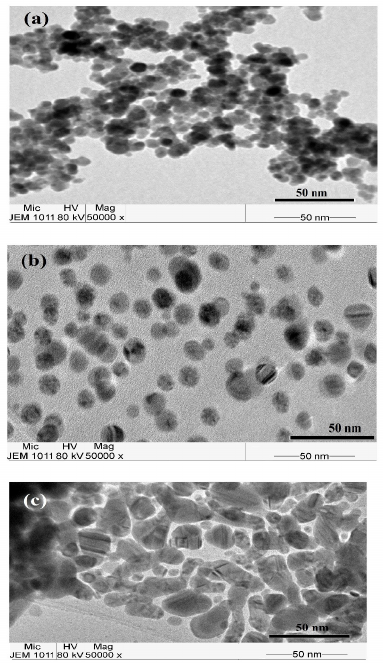
Figure 6. TEM micrographs of Ag capped with ( a ) EOA, ( b ) ELOA and ( c ) ELNA.